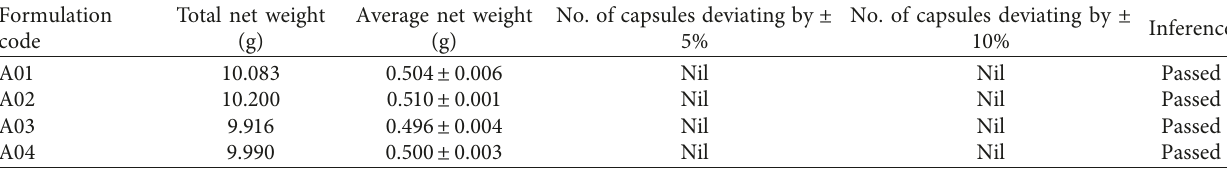
Table 3: Uniformity of weight of Antiaris africana capsules ( n � 20).